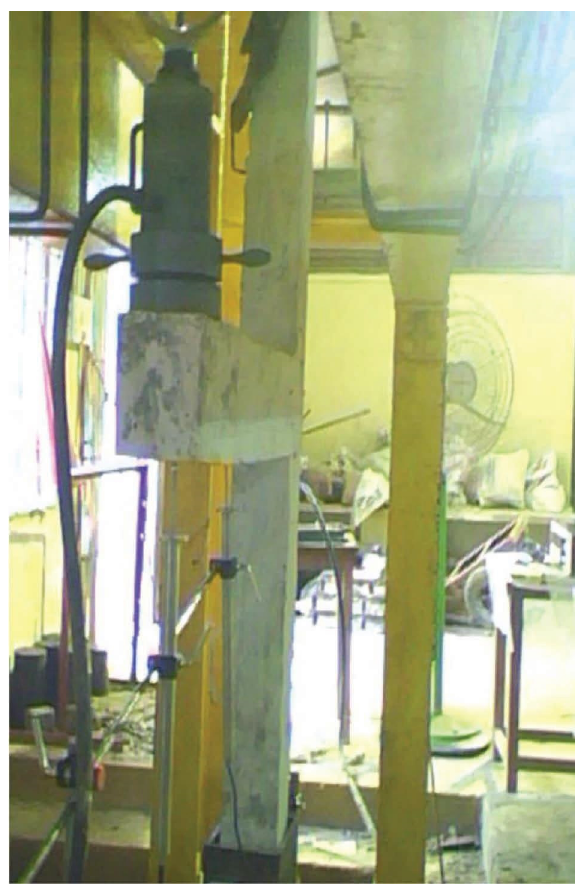
Figure 4: Actual test set-up on beam column joint under axial compression and